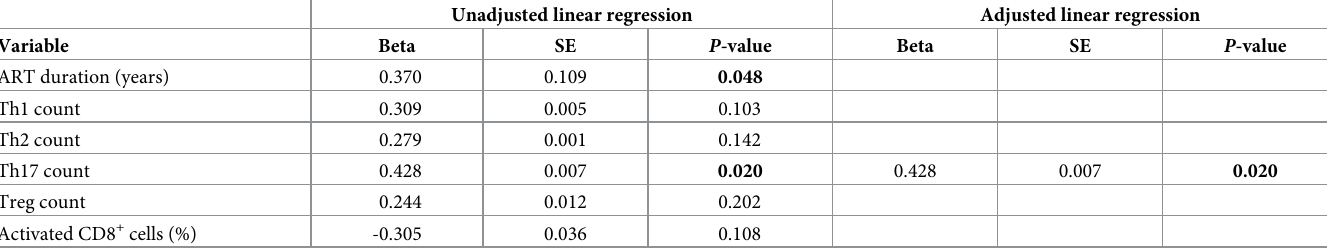
Table 3. Linear regression analysis of Staphylococcus with ART duration and immune status in the ART(+)